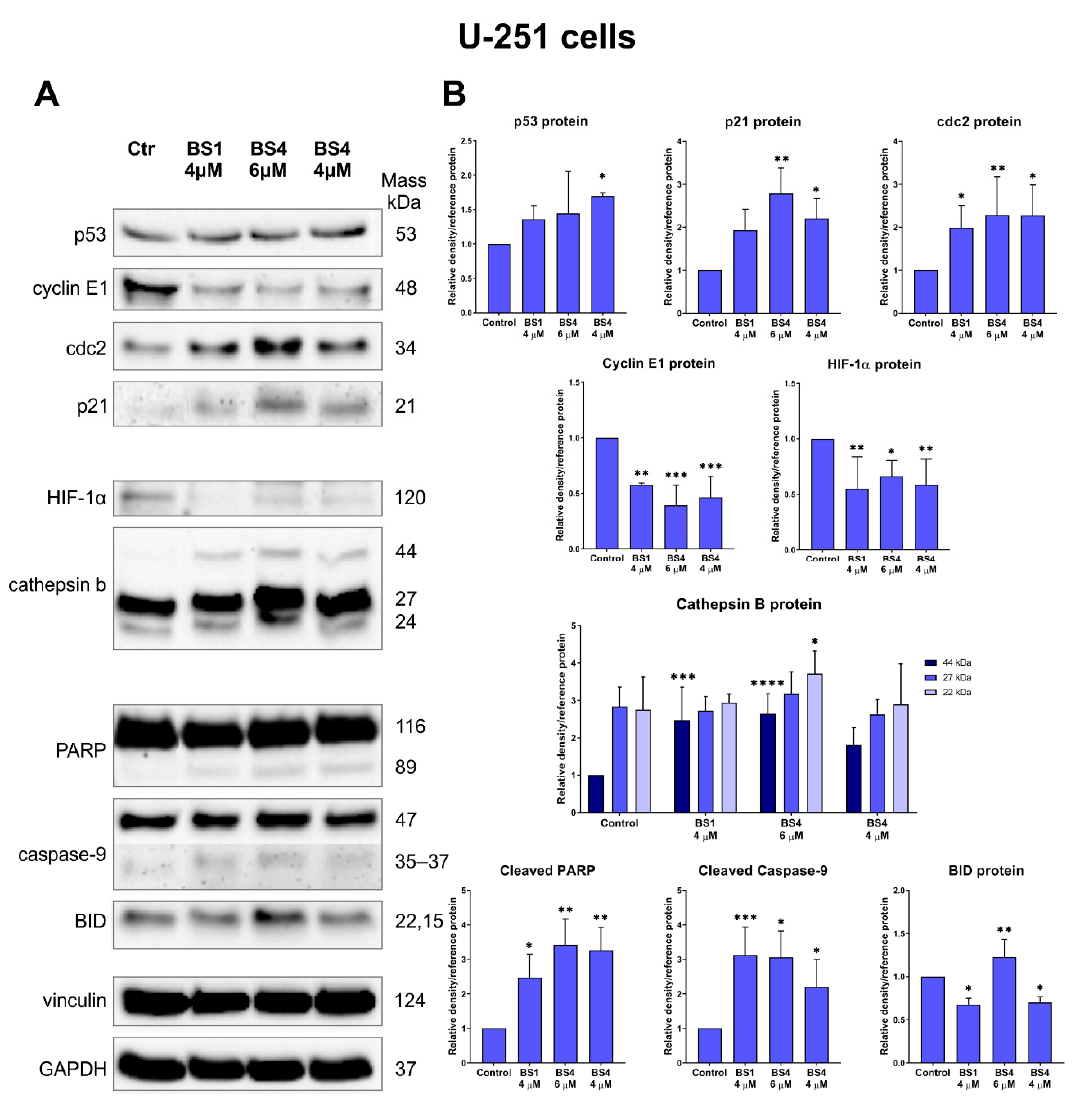
Figure 8. Impact of the tested derivatives ( BS1 , BS4 ) at various concentrations on the expression of selected proteins that are associated with cell cycle, apoptosis and oxidative stress in the U-251 cells ( A ). The densitometric analysis charts of obtained results were normalized to the reference protein and are presented as the mean ± SD of several independent experiments. The uncropped Western blots have been shown in Figure S22. ( B ). The statistical analysis was performed using a one-way ANOVA with Bonferroni’s post-hoc test: * p < 0.05, ** p < 0.01, *** p < 0.001, **** p < 0.0001 compared to the untreated cells (control, Ctr).